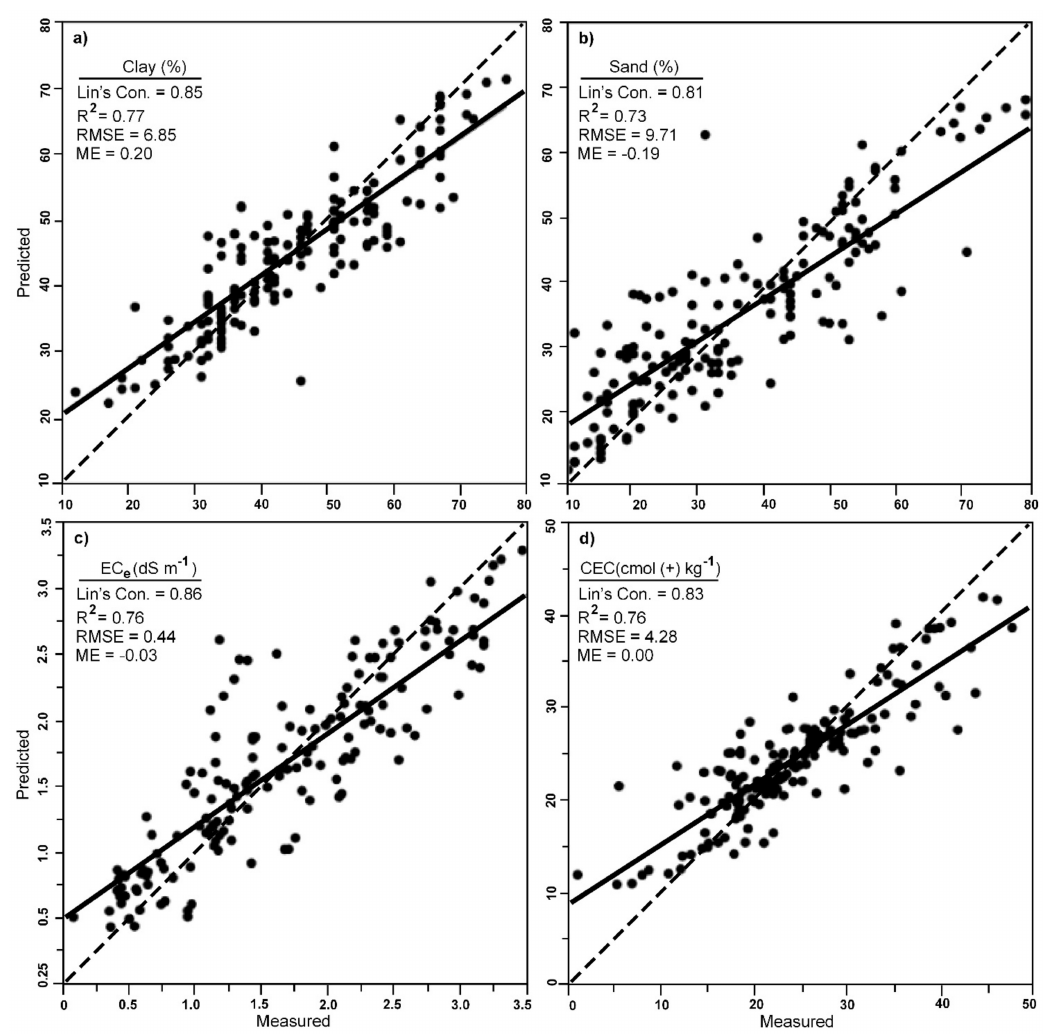
Figure 5. Leave-one-site-out cross-validation plots of measured versus predicted ( a ) clay (%), ( b ) sand (%,) ( c ) electrical conductivity of a saturated soil paste extract (EC e —dS m − 1 ) and ( d ) cation exchange capacity (CEC—cmol( + ) kg − 1